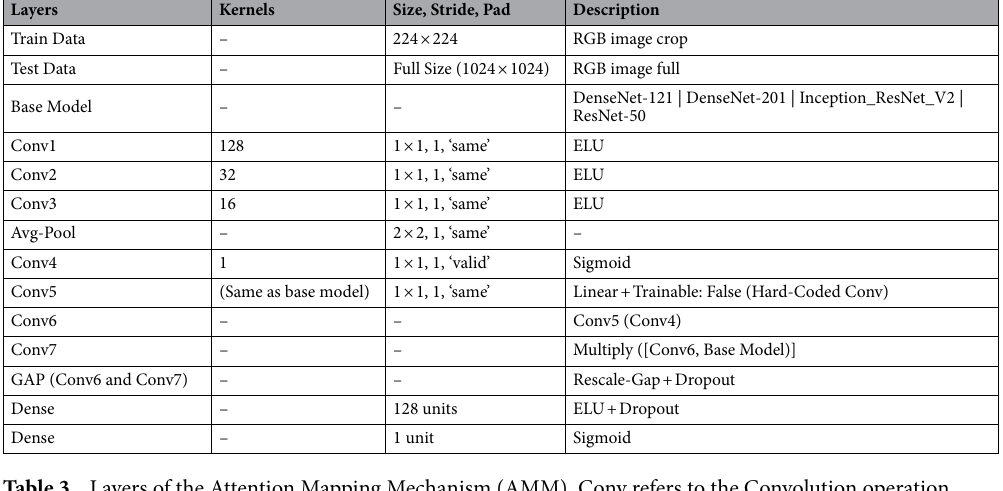
Table 3. Layers of the Attention Mapping Mechanism (AMM). Conv refers to the Convolution operation. During training, we scale down the image into 224 × 224 pixels, where testing is performed on the entire input